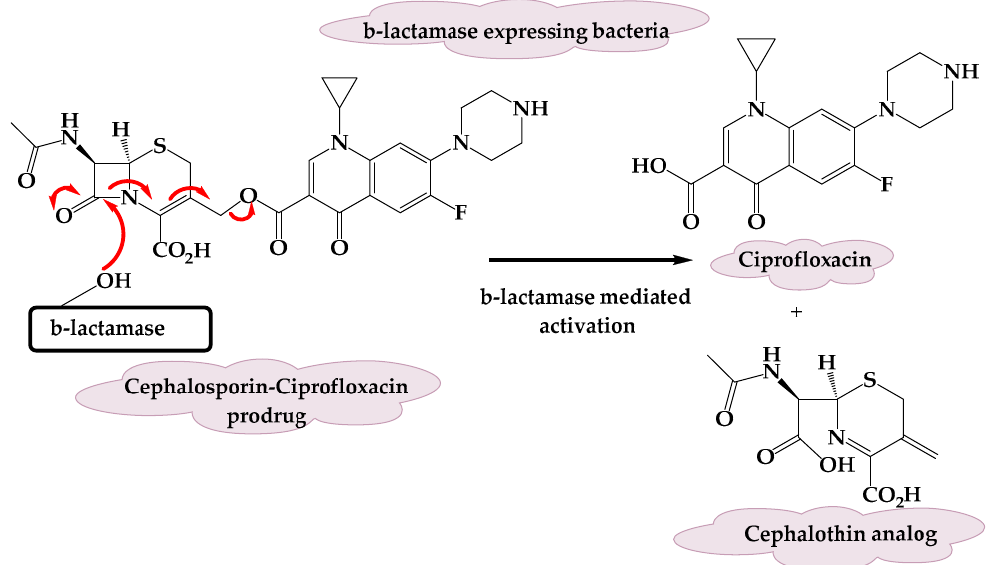
Figure 4. Mechanism of activation of the cephalosporin-ciprofloxacin prodrug.